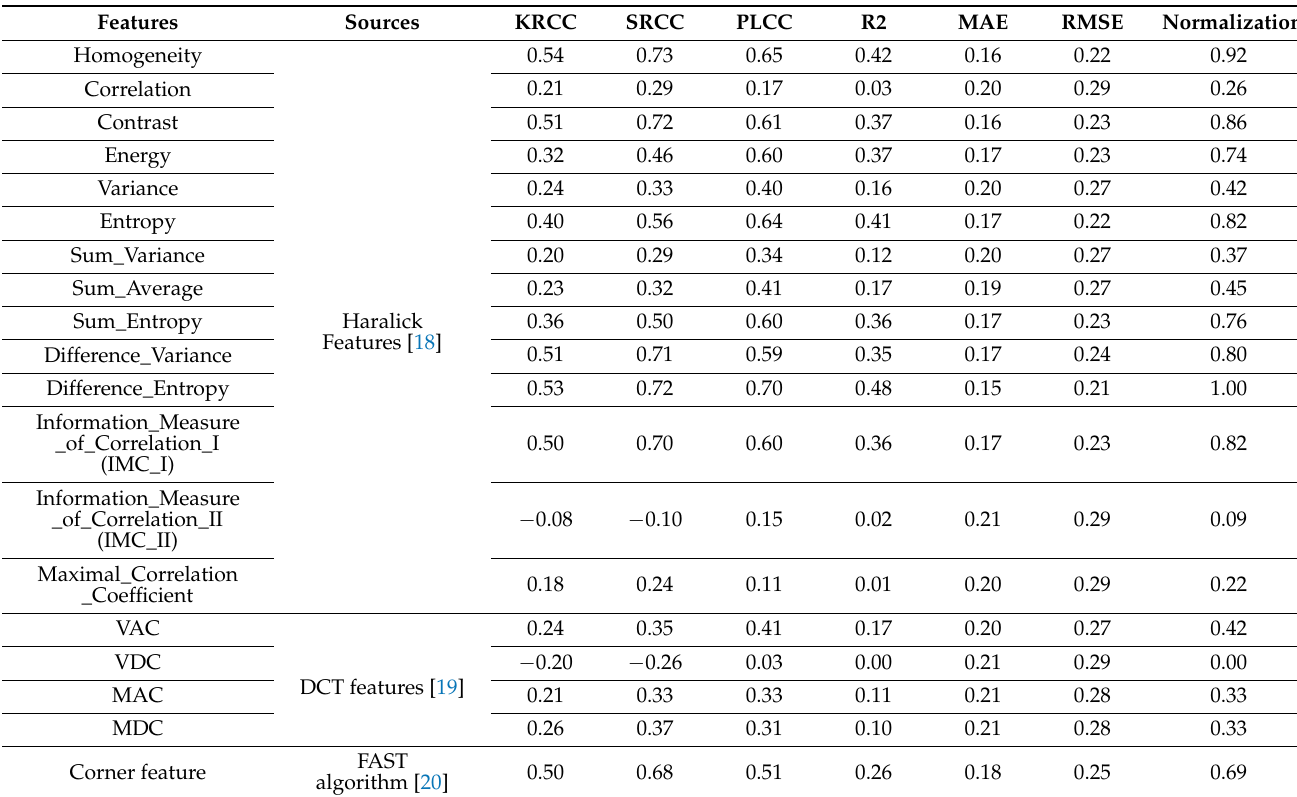
Table 4. Performance of individual features versus mixed model random effort intercept